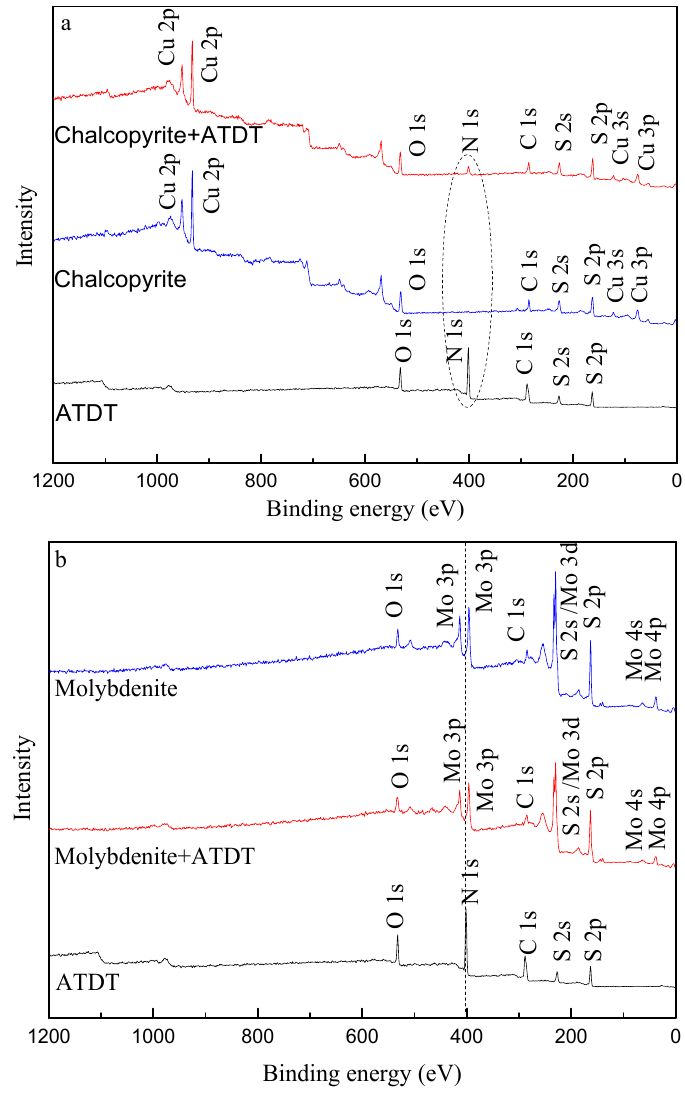
Figure 8. The survey (full range) XPS spectrums of ( a ) ATDT and Chalcopyrite before and after treatment; and ( b ) molybdenite before and after treatment.